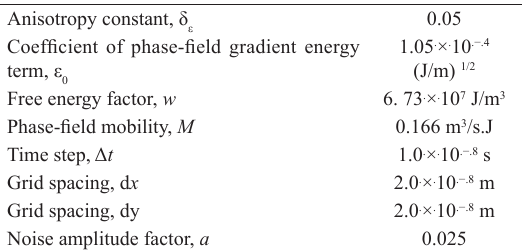
Table 4. Computational parameters.